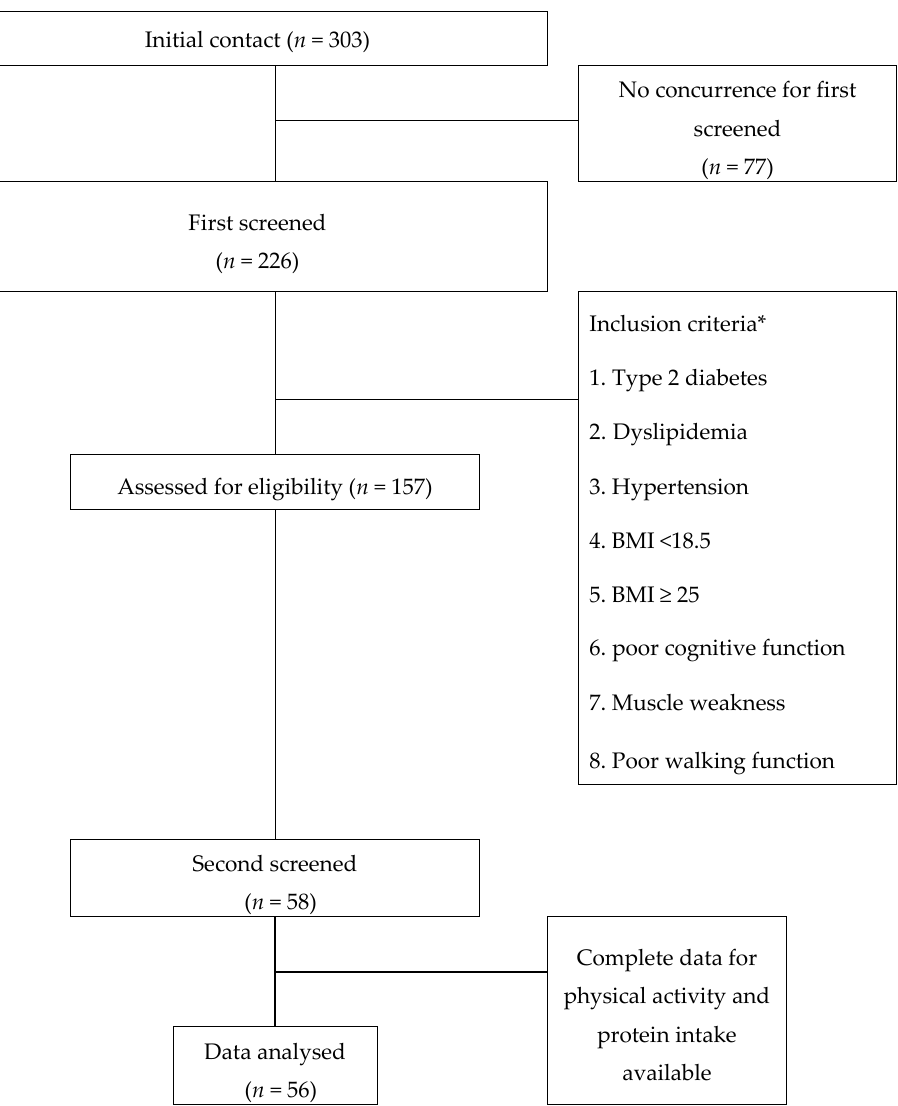
Figure 1. Flow diagram for the identification, screening, eligibility and statistical analysis